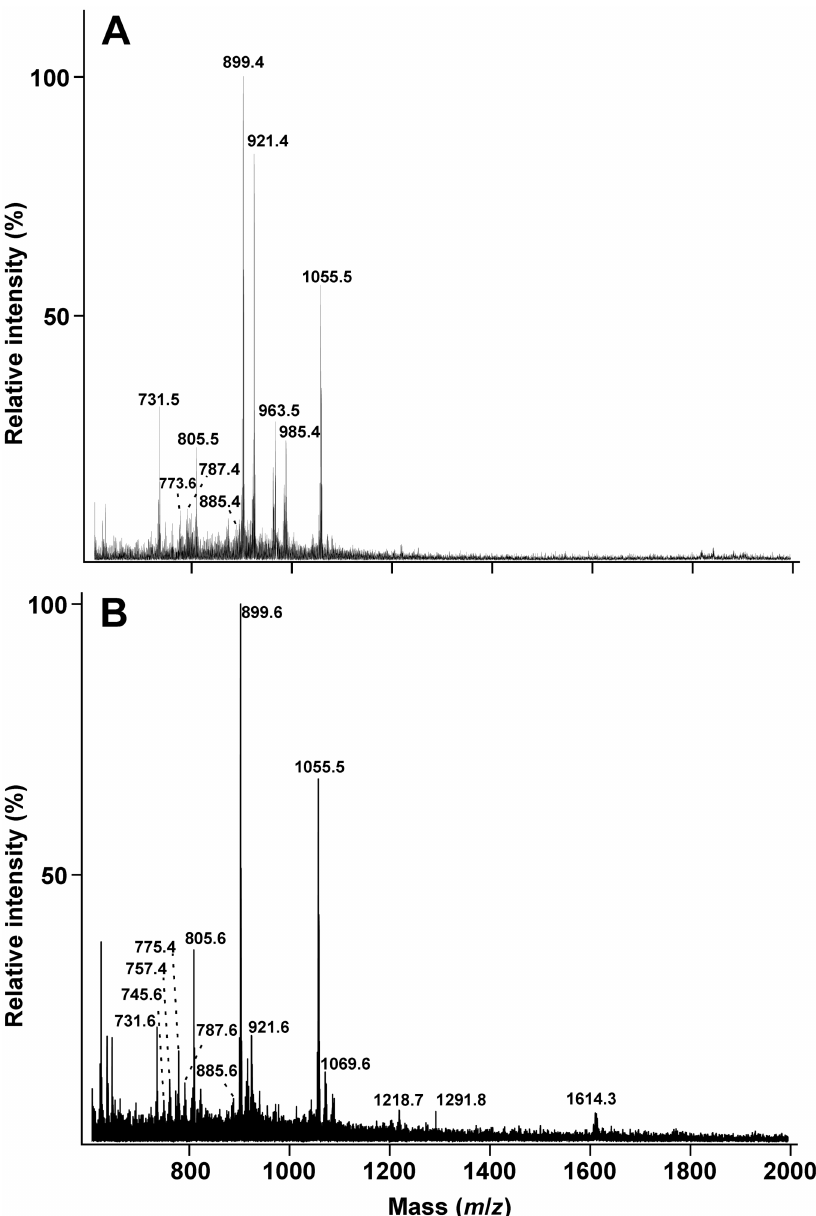
Figure 2. Negative-ion FAB MS spec- tra of the total polar lipids from Halo- coccus morrhuae strains 16008 (panel A) and 14039 (panel B). Assignments are reported in the legend to Figure 1, except new signals at m / z = 963.5 and 985.4 (+ Na + ) in panel A, which are in- terpreted as propionic acid or butyl variations replacing the methyl moiety of PGP-methyl. Note the unidentified signals at m / z = 1291.8 and 1614.3 in panel